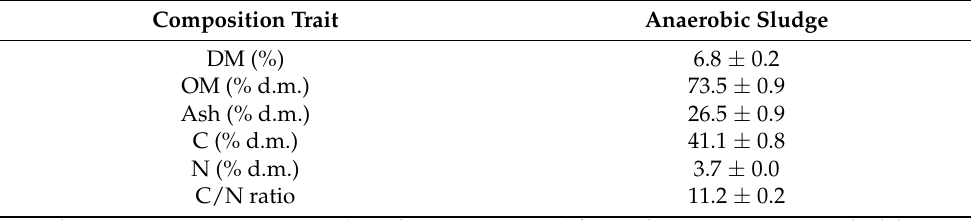
Table 2. The parameters of anaerobic sludge inoculum used in respirometers. Composition